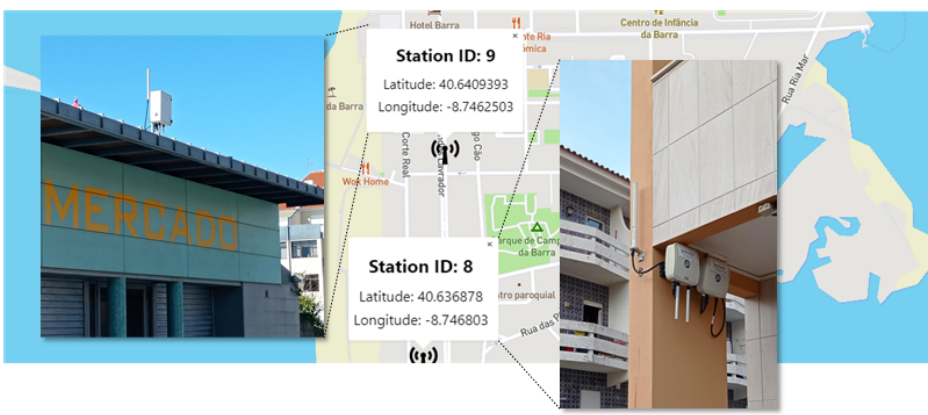
Figure 13. RSUs installed with commercial fiber optics